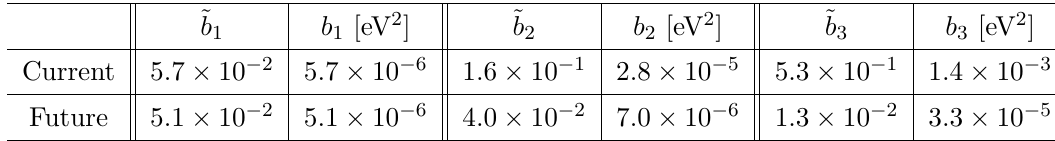
Table 1. Current and future (expected) terrestrial constraints on ˜ b i ≡ b i /m 2